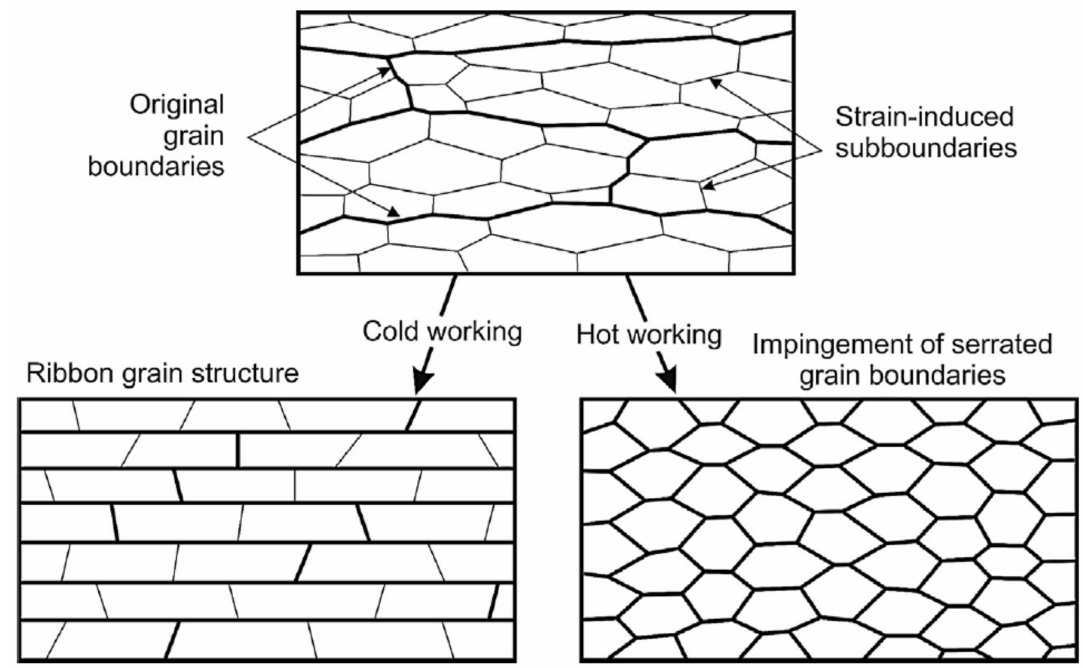
Figure 15. Schematic of ultra-fine grain (UFG) development during unidirectional plastic working to large strains. Directional ribbon grain structures formed by a grain subdivision process at room temperature or through the geometric dynamic recrystallization at elevated temperatures